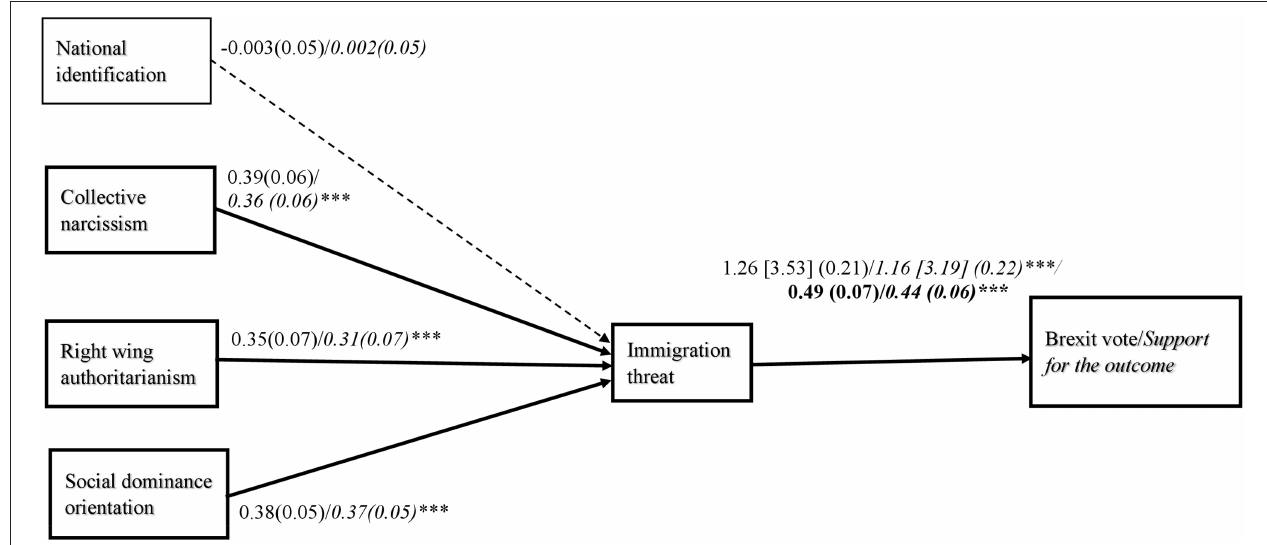
FIGURE 1 | Relationship between variables in Study 1. Coefficients for the binary outcome variable represent log odds [odd ratios] and standard errors are in parentheses. Coefficients for the continuous variables represent unstandardized regression weights. Numerals in italic font correspond to analyses with covariates (national identification, age, gender, education, ethnicity, and indicated national group). Numerals in bold font correspond to unstandardized regression weights and standard error in analyses predicting the continuous support for the outcome of the referendum. *** p <